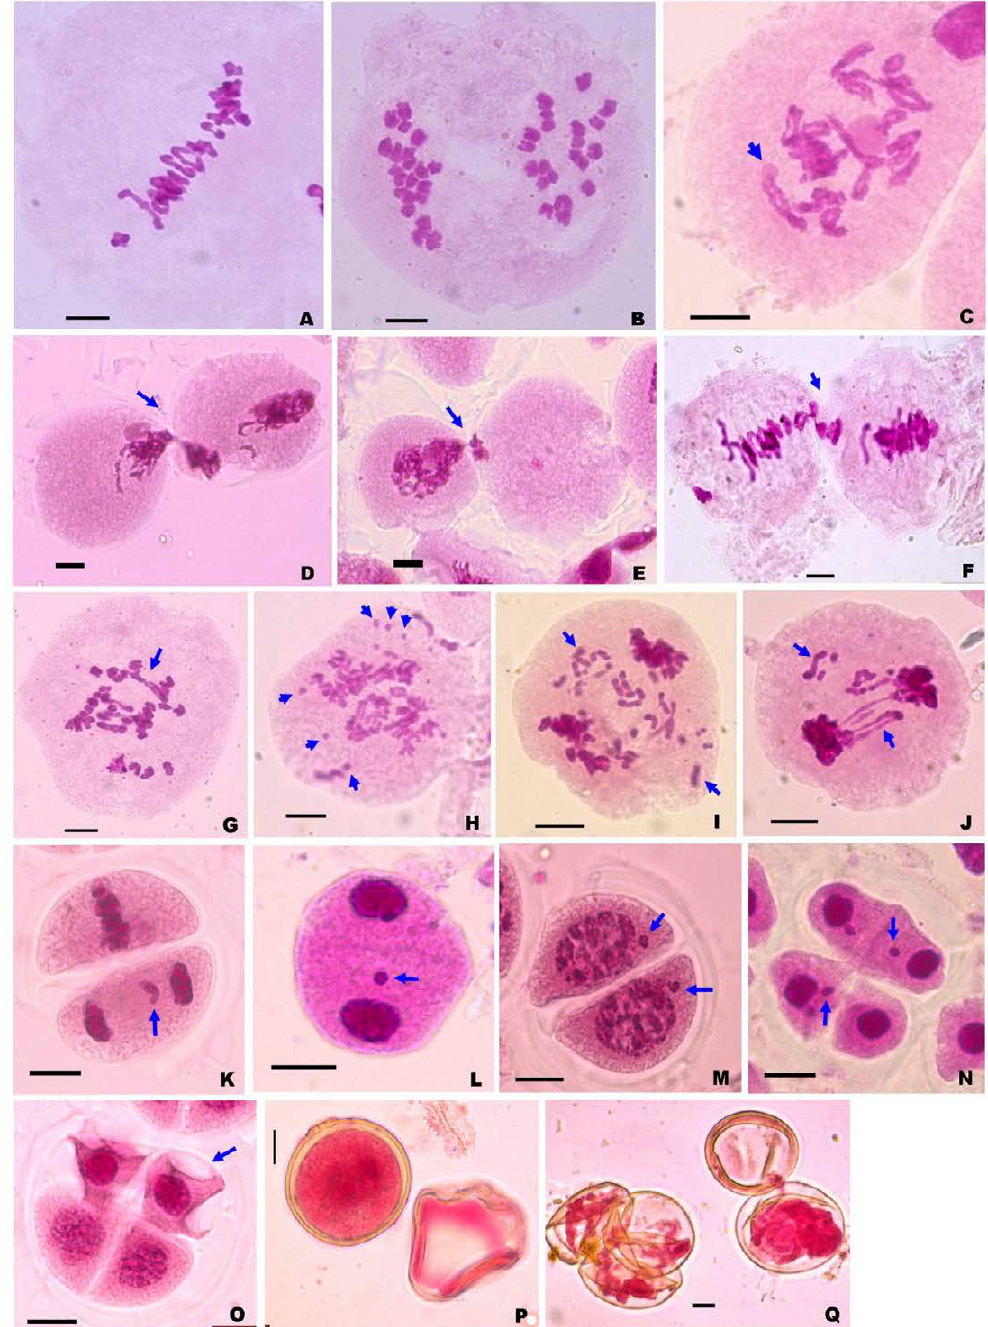
Figure 1. Male meiosis in Agropyron thomsonii : (A) M-I PMCs with 21 bivalents (B) A-I PMC with 21:21 chromosomes at each pole; (B) PMCs involved in chromatin migration at P I (arrowed); (C) a diakinesis PMC possessing relatively small sized additional nucleolus PMCs; (D) prophase-I PMCs depicting phenomenon of cytomixis (arrowed); (E) diakinesis PMCs with chromatin migration and depicting forma- tion of hyperploid and enucleated PMC (arrowed); (F) M-I PMC involved in chromatin migration (arrowed); (G) A-I PMC with non-syn- chronous dysjunction of bivalents depicted by univalents and bivalent bridges (arrowed); (H) a PMC depicting abnormal spindle and state of pycnosis with fragments (arrowed); (I) A-I PMC with several laggards (arrowed); (J) early T-I PMC with dicentric bridge, fragments and laggards (arrowed); (K) T-II PMC as dyad with on subunit with laggard (arrowed); (L) T-I PMCs with miocronuclei at one pole (arrowed); (M) dyad subunits with micronuclei (arrowed); (N) tetrad microspore subunits with micronuclei (arrowed); (O) A tetrad with two shriv- elled microspore units (arrowed); (P, Q) fully stained fertile, shrivelled and unstained as sterile pollen grains. Scale bar=10 μ